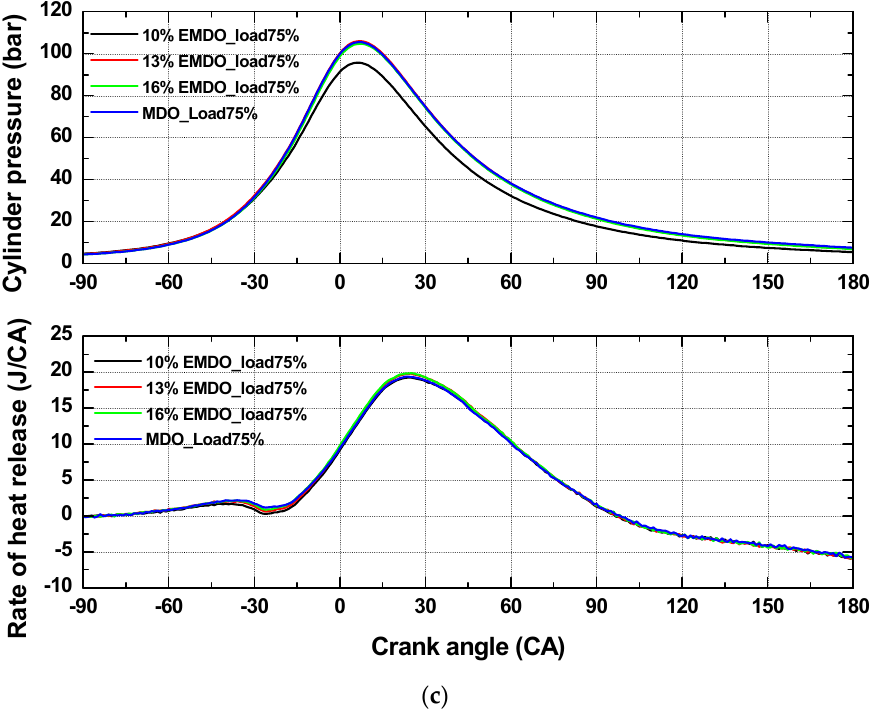
Figure 4. Characteristics of cylinder pressure and heat release with MDO and emulsified fuel according to moisture content: ( a ) Load 25%; ( b ) Load 50%; ( c ) Load 75%.